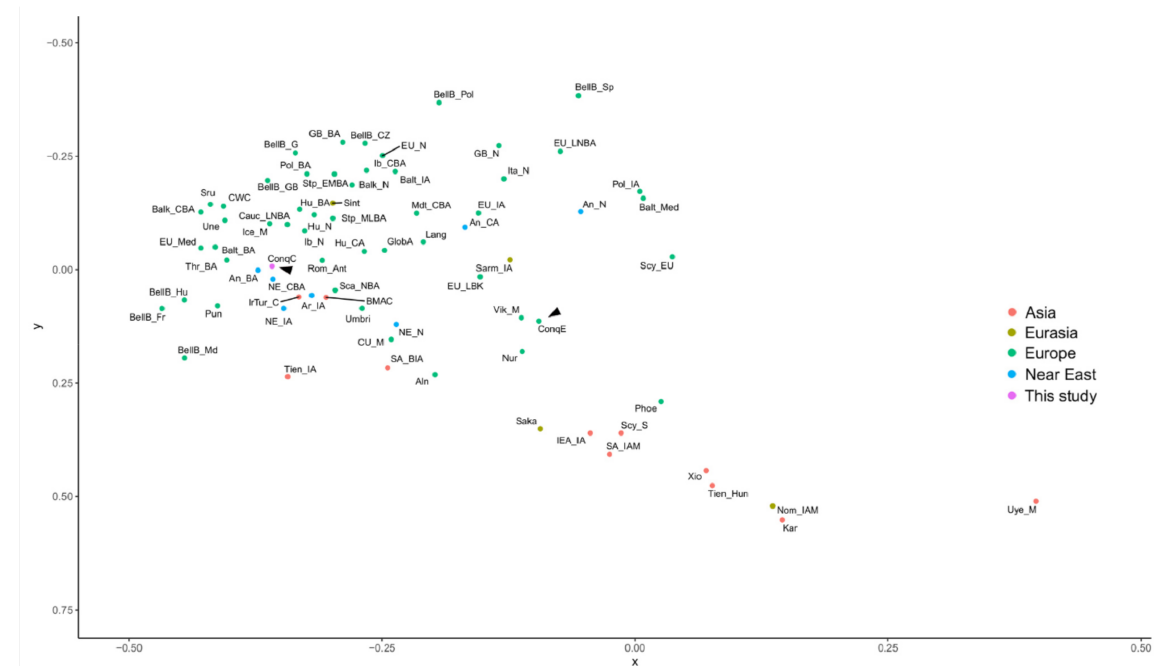
Figure 5. A multi-dimensional scaling (MDS) plot from the linearized Slatkin Fst values from Table S5a. Abbreviations of the population names are given in Table S4b. European populations are sequestered to the left and Asian populations are sequestered to the bottom right. Color shading denotes geographic regions as indicated. ConqC and ConqE are highlighted with